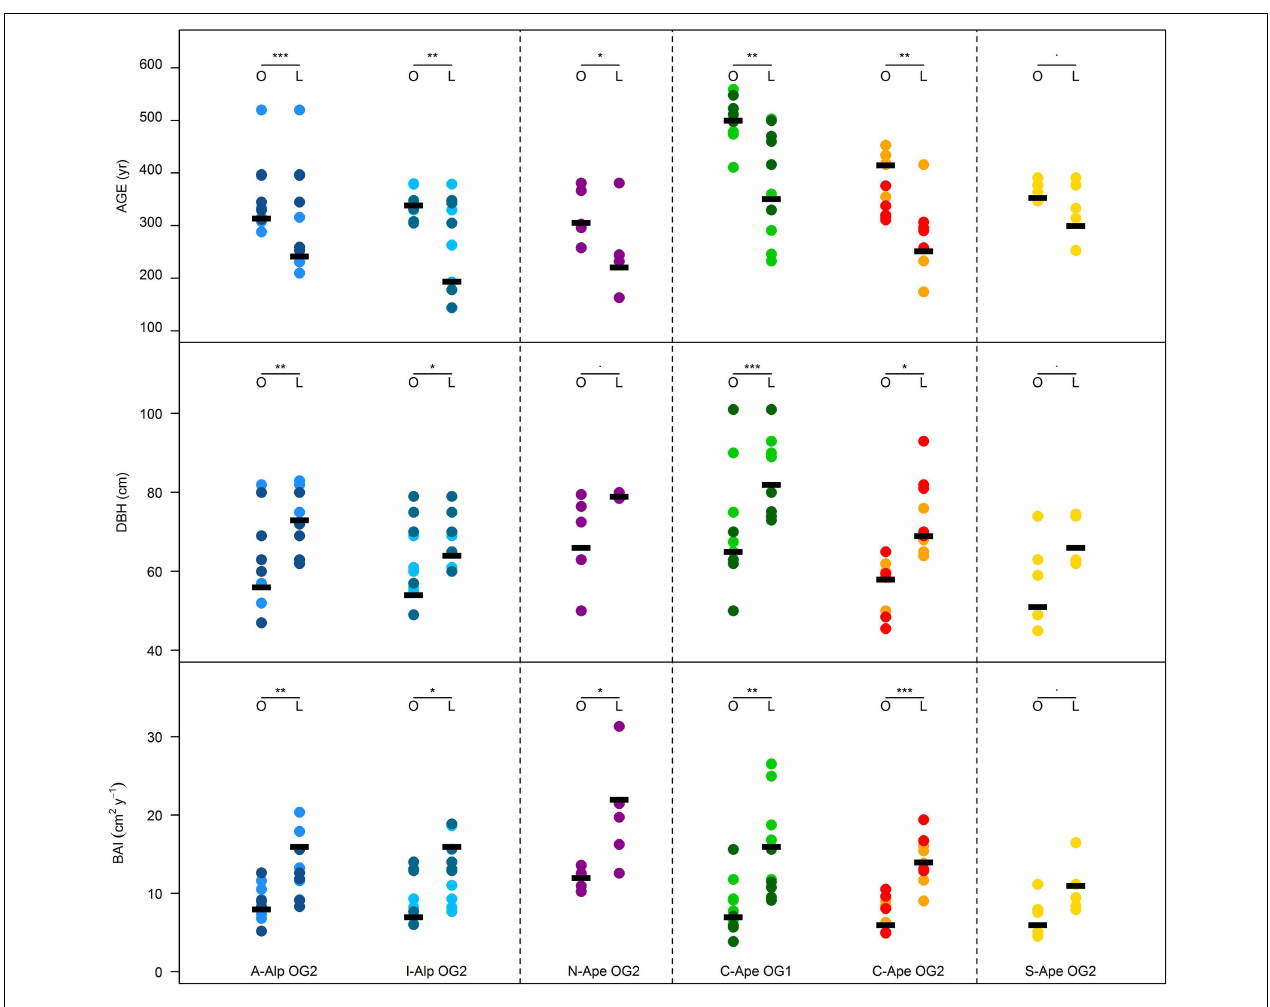
FIGURE 5 | Comparison between the age, DBH and overall Basal Area Increment (BAI) of the 5 oldest (O) and largest (L) beech trees within high-elevation forests. The difference in mean (thick black lines) was tested by a Welch’s t test ( *** : P ≤ 0.001; ** : P ≤ 0.01; * : P ≤ 0.05; “.”: P ≤